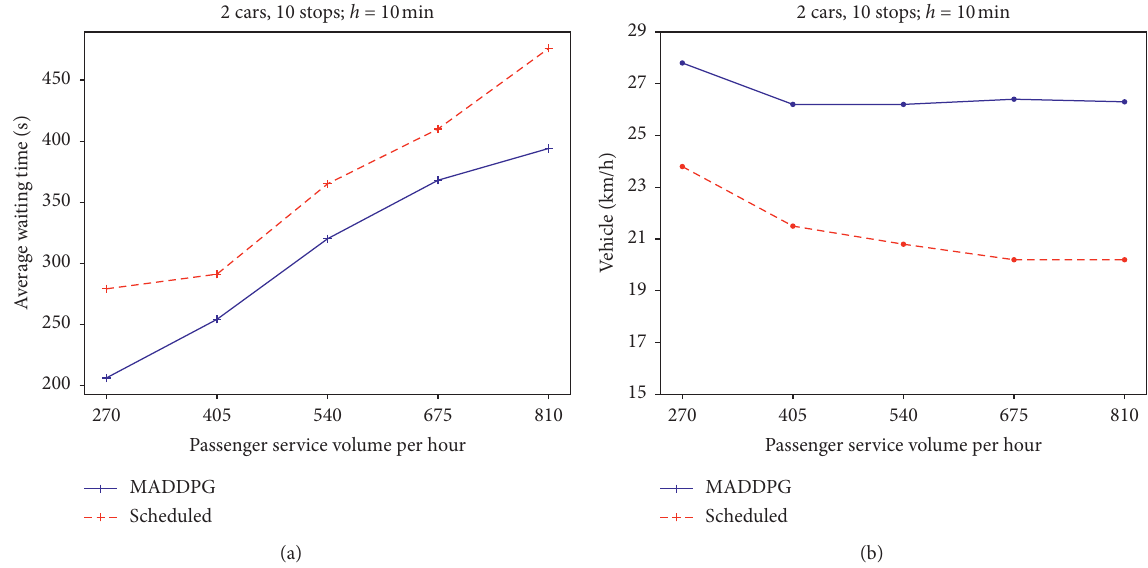
Figure 8: Performance comparison between the MADDPG and SCHEDULED methods in Scenario 2 based on the average passenger wait time and